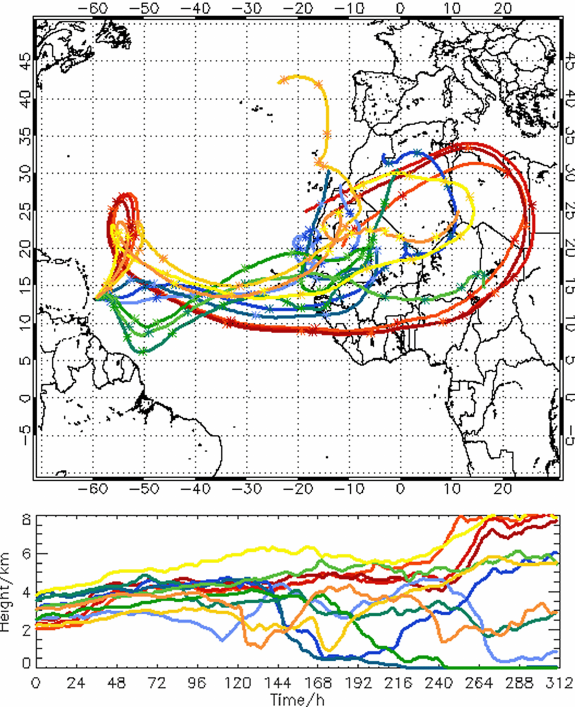
Figure 2. Shown are 312h backward trajectories calculated with the Hybrid Single Particle Lagrangian Integrated Trajectory (HYS- PLIT) model (Draxler and Rolph, 2012) and GDAS meteorological data for the pure dust layers on 20 June 2013, 23:00UTC (red), 27 June 2013, 01:00UTC (blue), 1 July 2013, 08:00UTC (green), and 11 July, 23:00UTC (yellow). The stars along the trajectories indicate 24h time steps. The height range of the pure dust layers is indicated in Table